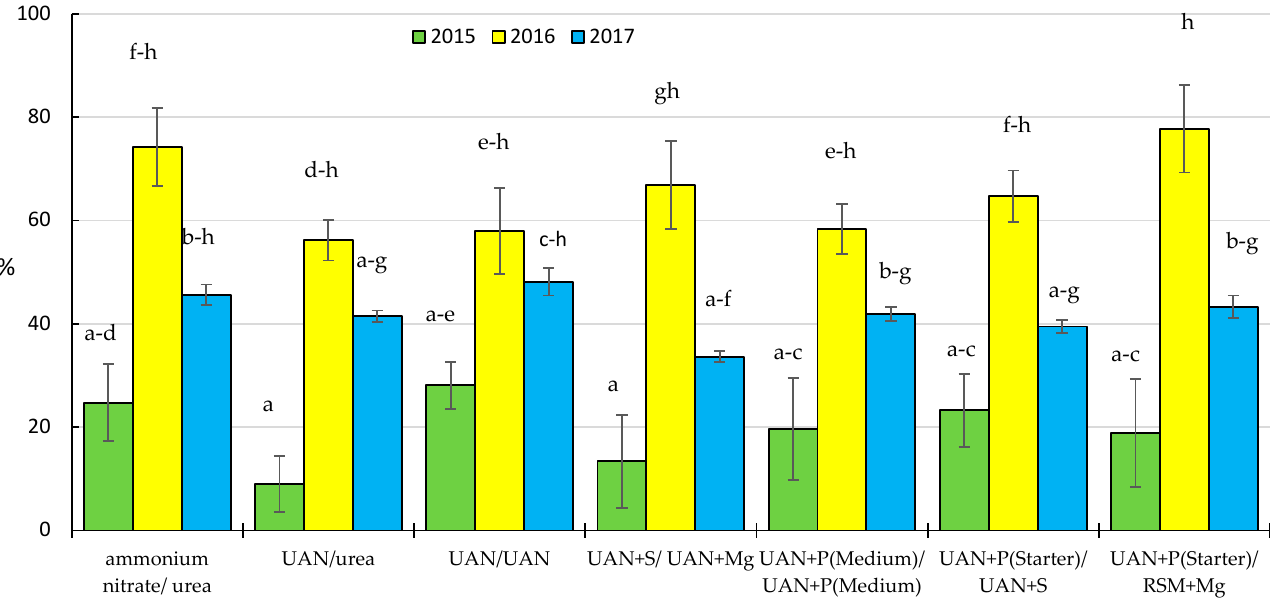
Figure 6. Recovery of N from mineral fertilizers (R N ) in the years of the experiment depending on the applied fertilization (mean ± SE; data marked with same letters do not differ significantly at p < 0.05), years of experiment (2015, 2016 and 2017) and treatments (see Table 1). The R N in the years of the study was significantly varied (Figure 7a). The highest R N (62%) was recorded in the second year of the trials. In turn, the lowest R N (20%) appeared in the first year, in which the maize yield was the lowest because of a considerable shortage of rainfall. On average for the entire experiment, the lowest R N (35%) was noted in the object fertilized with UAN before sowing and with urea by top-dressing (Figure 7b). The highest value (48%) of this indicator was achieved when fertilizing maize with UAN + P (Starter) before sowing and with UAN + Mg by top-dressing. However, because of high fluctuations between the research years, differences in the R N between the treatments were not significant